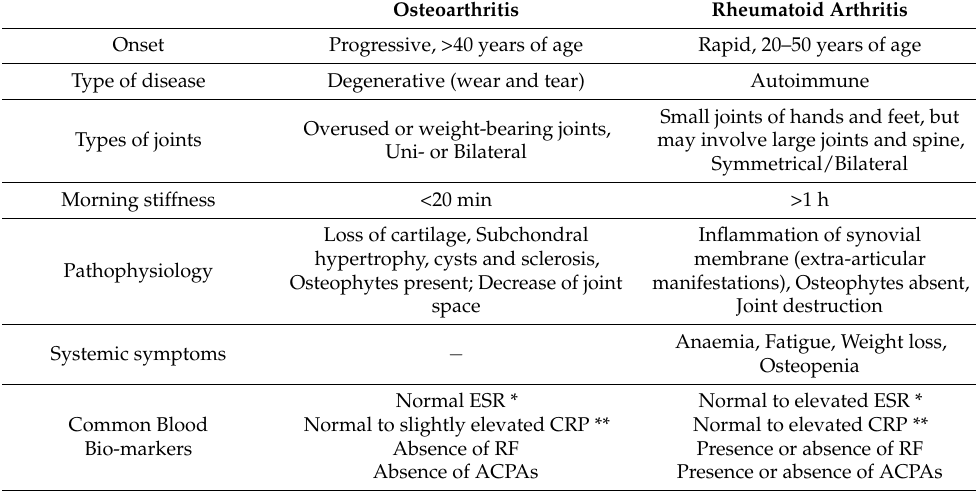
Table 1. Differences between osteoarthritis and rheumatoid arthritis.